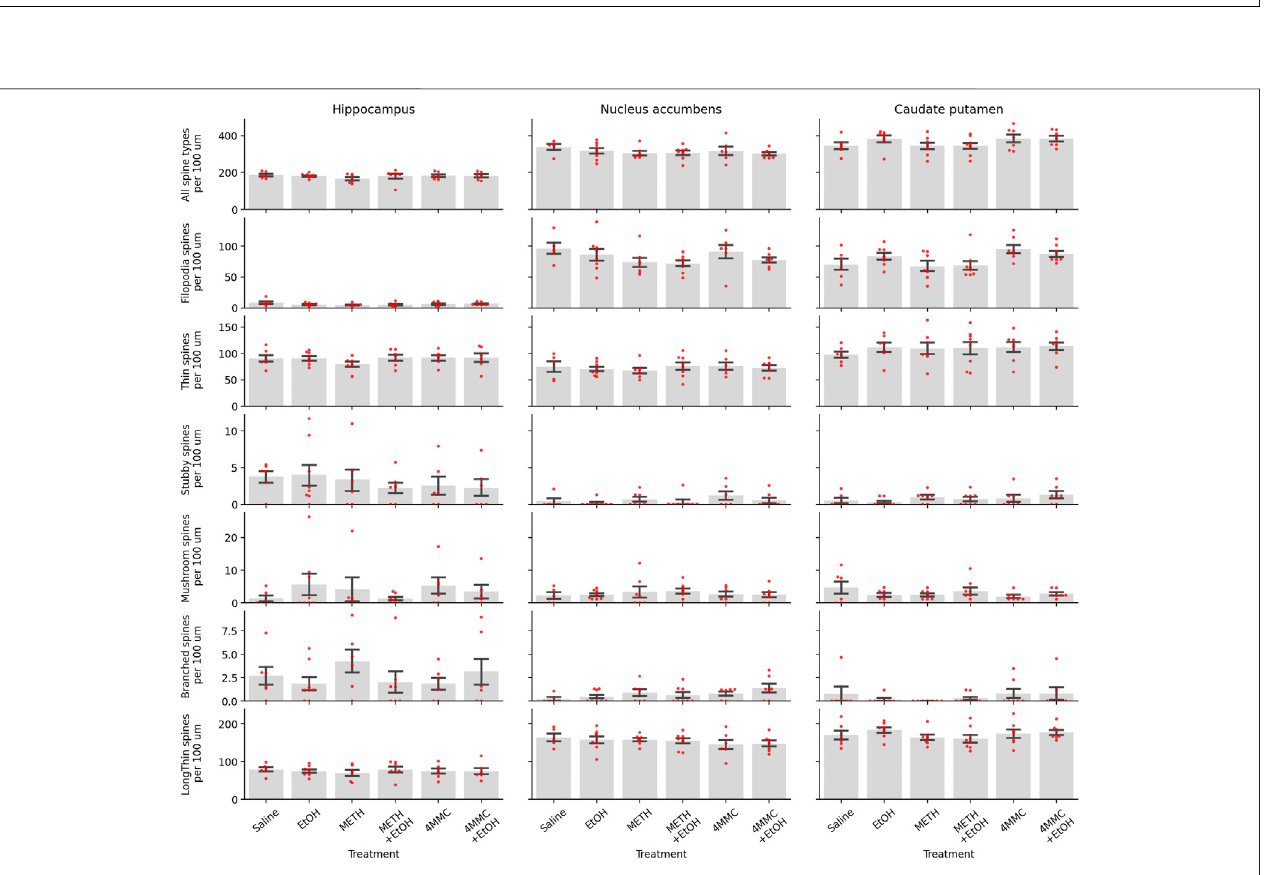
FIGURE 5 | Spine density per spine type shown in the hippocampus, nucleus accumbens and caudate putamen. Individual data points shown in red, bars represent data as mean ± SEM.